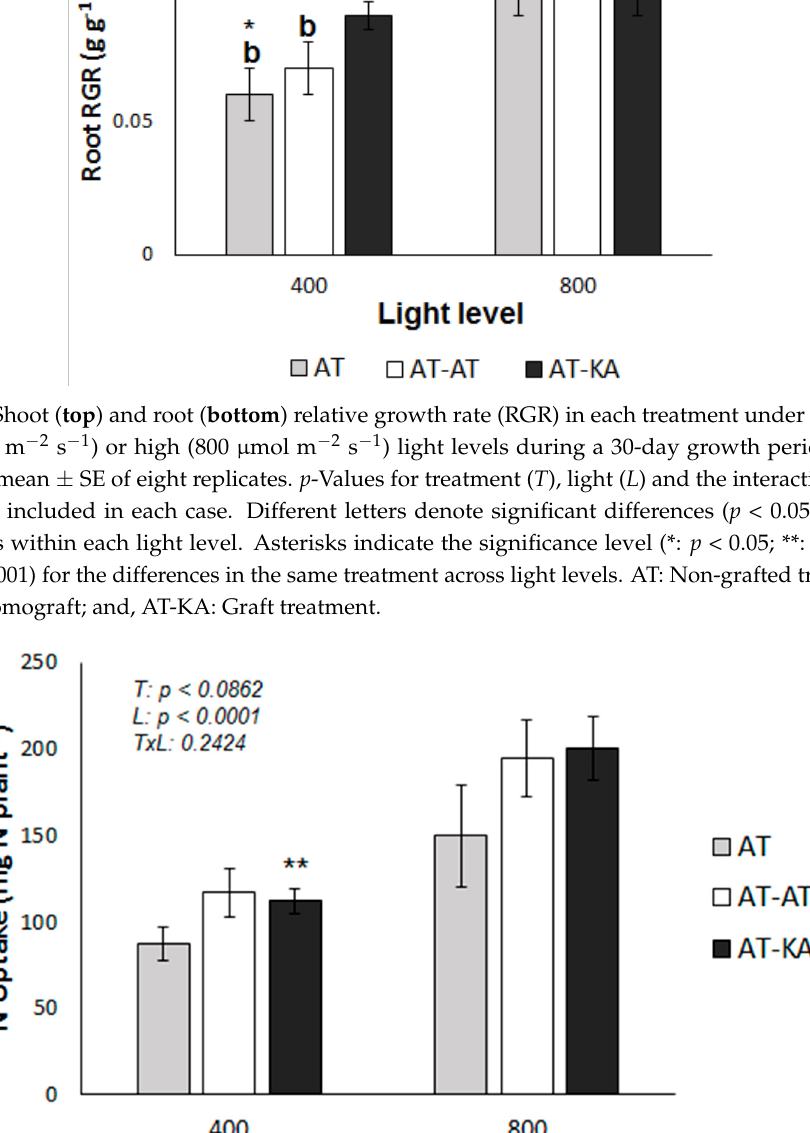
Table 1. Tissue N content in each treatment under medium or high light intensity. Data are means of four biological independent replicates ± SE. Different letters in the same column denote significant differences ( p < 0.05). AT: Non-grafted treatment; AT-AT: Homograft; and, AT-KA: Graft treatment. Treatment